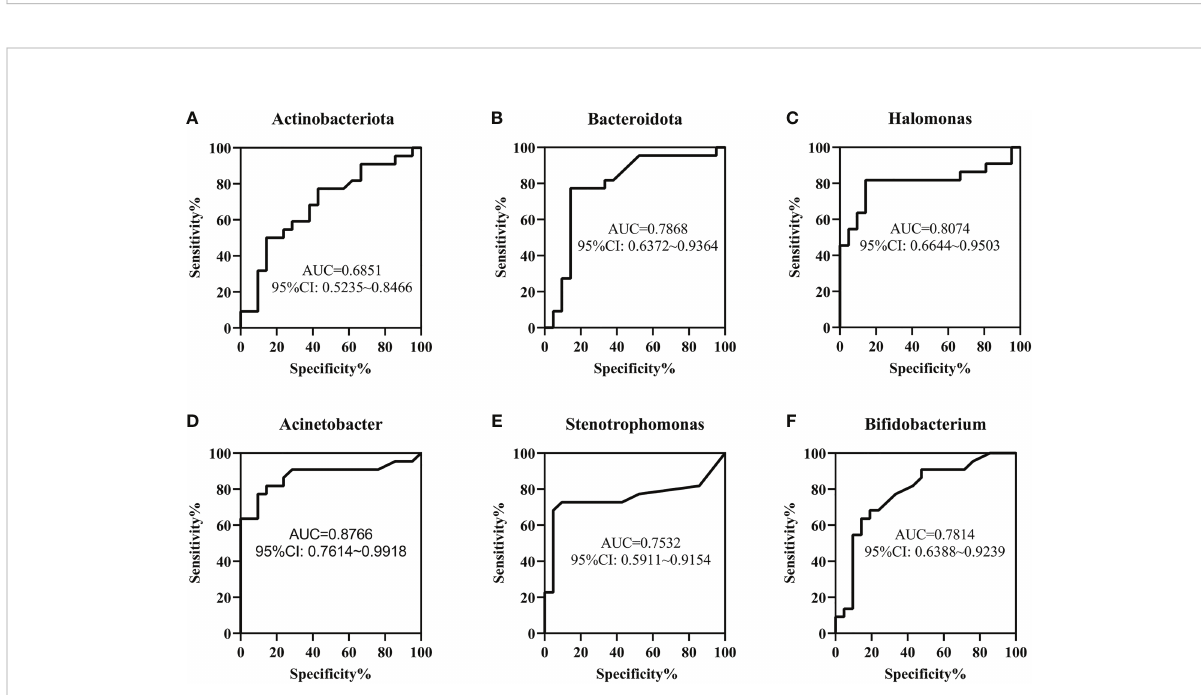
FIGURE 5 The value of gut microbiota in the early identi fi cation of necrotizing enterocolitis (NEC) and food protein-induced allergic protocolitis (FPIAP) by receiver operating characteristic (ROC) analysis. The area under curves ( AUCs) of Actinobacteriota (A) , Bacteroidota (B) , Halomonas (C) , Acinetobacter (D) , Stenotrophomonas (E) , and Bi fi dobacterium (F) were 0.6851, 0.7868, 0.8074, 0.8766, 0.7532, and 0.7814, respectively. N =22 for NEC and N =21 for FPIAP.